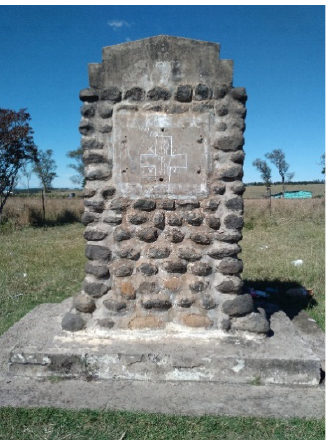
Figure 5: Battle of Draaibosch Memorial with interpretative plaque removed.